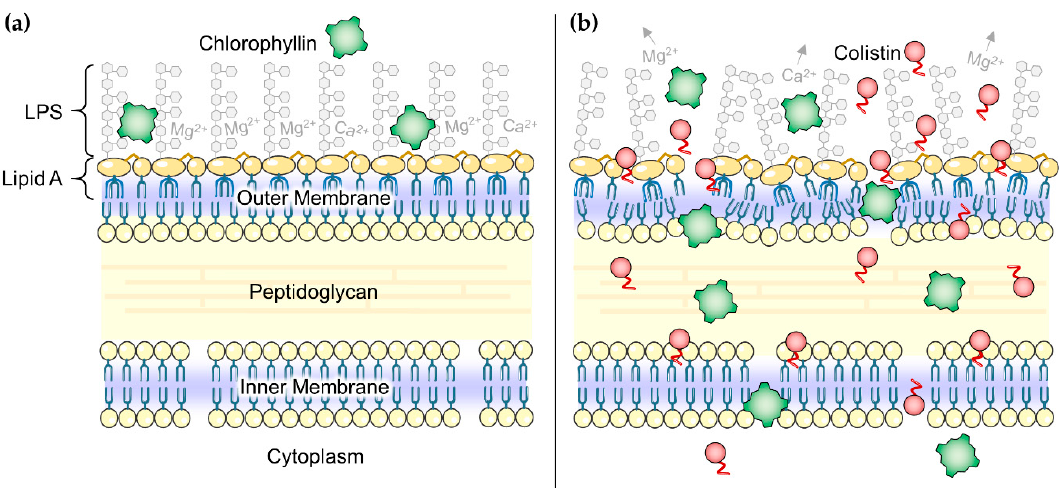
Figure 7. ( a ) Schematic illustration of the Gram-negative envelope. Chlorophyllin (green squares) is not able to pass the outer membrane; ( b ) In the presence of colistin (red circles) the outer membrane is disorganized, mainly by colistin’s effect to interact with lipopolysaccharides (LPS). Chlorophyllin can enter the bacterial cell through the disorganized membranes, realizing its antibacterial effect. Parts of the figure were drawn by using pictures from Servier Medical Art, licensed under a Creative